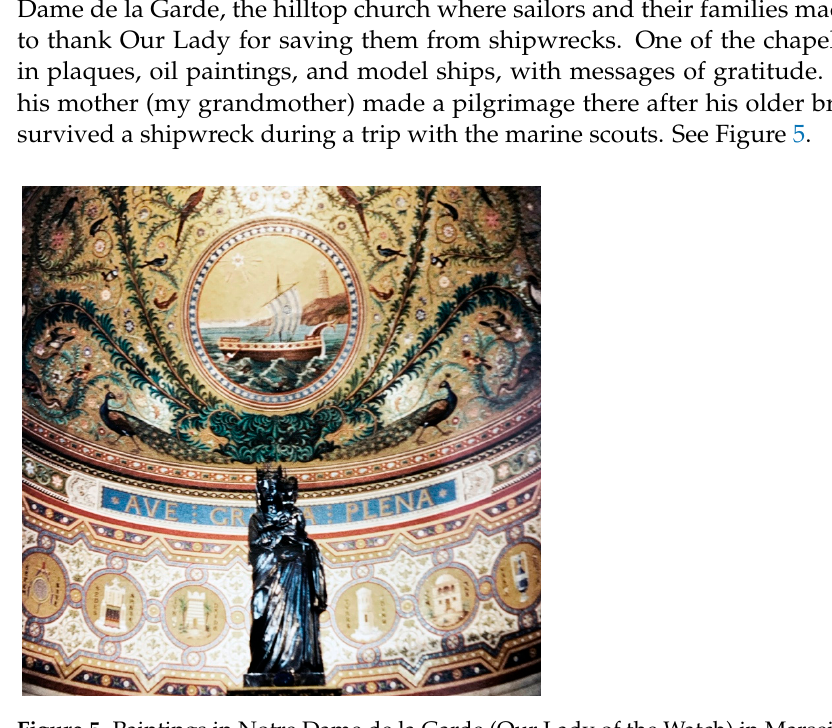
Figure 5. Paintings in Notre Dame de la Garde (Our Lady of the Watch) in Marseille include ships sailing into harbor. Photograph by Helen A. Regis.